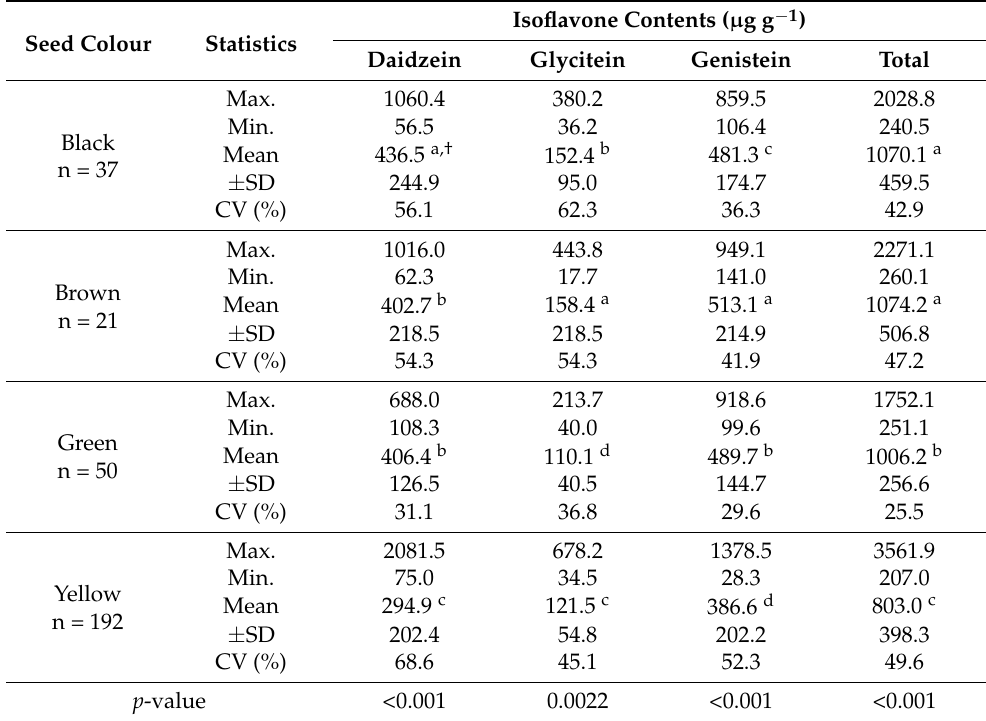
Table 7. Maximum, minimum and mean value of isoflavone contents according to seed colour in 300 soybean germplasms.